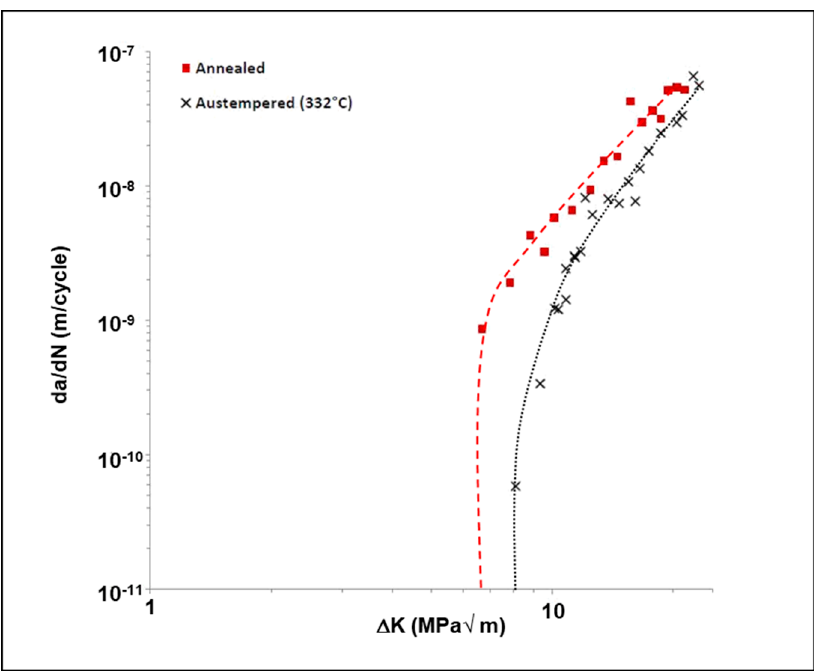
Figure 5. The Effect of Austempering on the Fatigue Crack Growth Rate of Uncharged 4140 Steel in the Threshold Region.